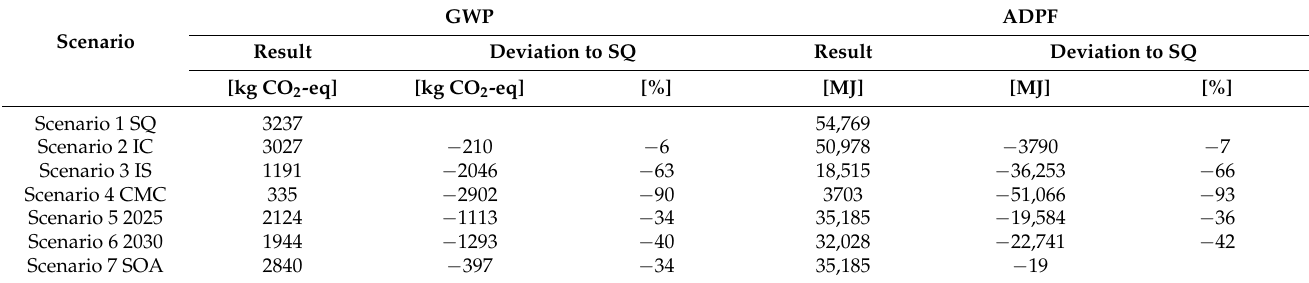
Table 10. Results and deviations of the impact assessment compared to the SQ.